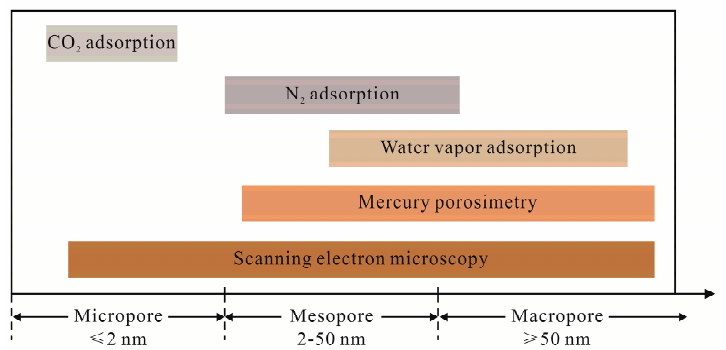
Figure 10. Comparison of the measurable ranges of the methods for coal pore sizes.